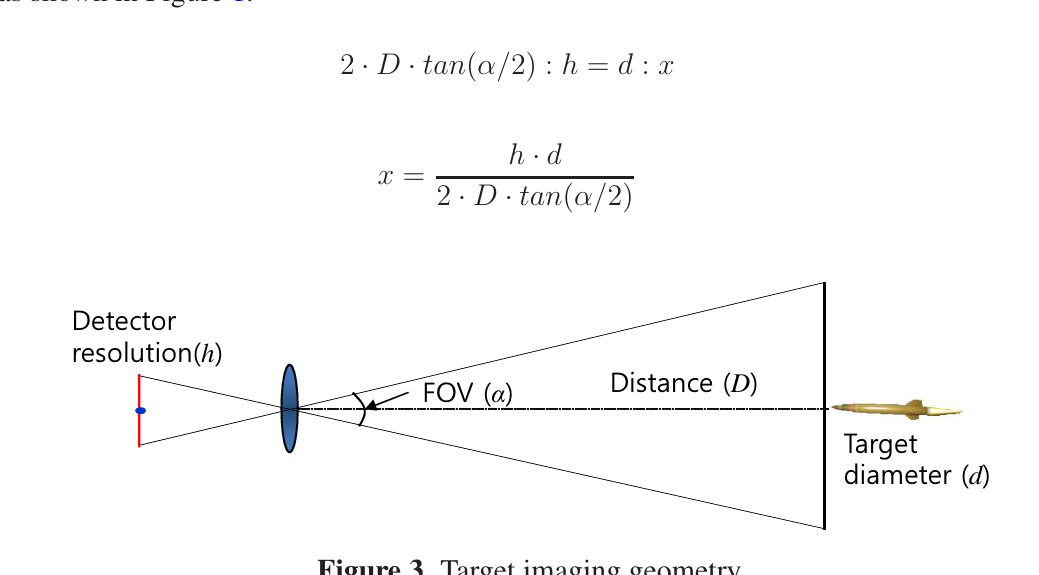
Figure 3. Target imaging